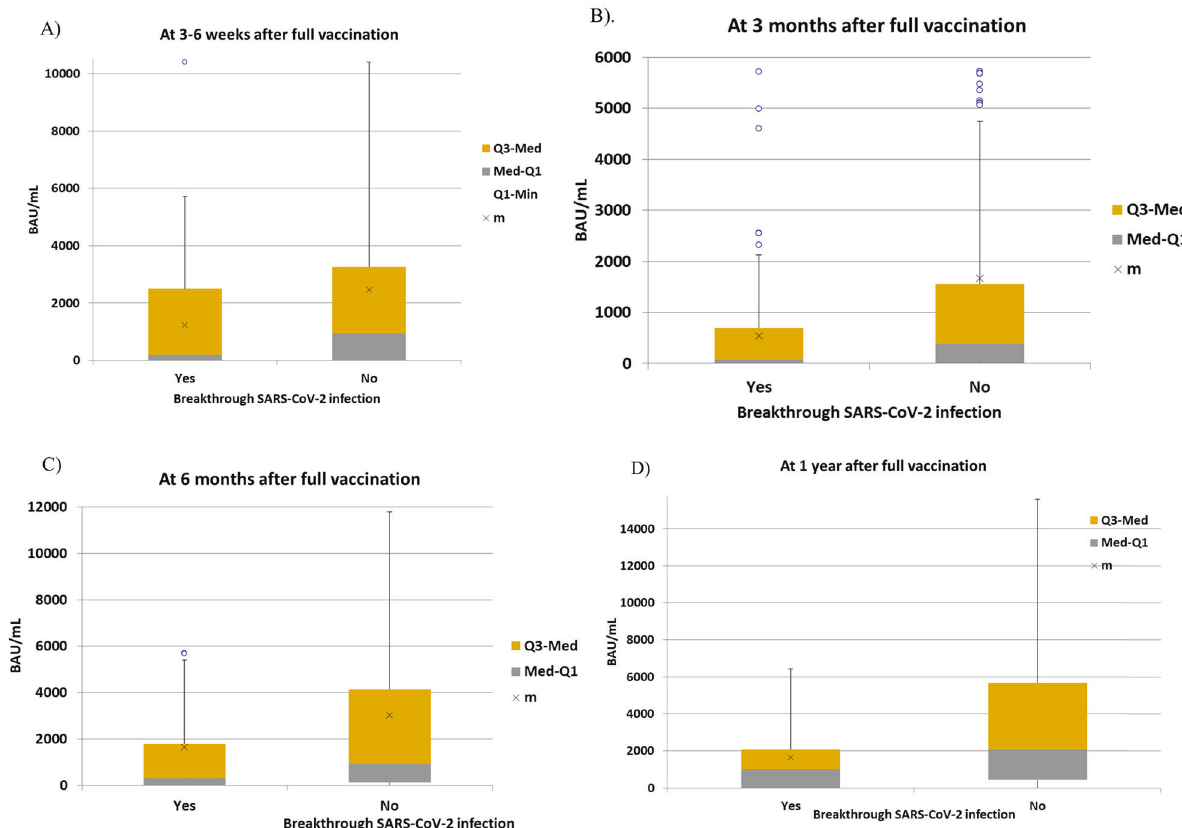
Fig. 3 Median anti-SARS-CoV-2 IgG reactive antibodies titers measured in binding antibody units/mL (BAU/mL) at 3 – 6 weeks, 3 months, 6 months and 1 year after the 2nd dose according to the development of breakthrough SARS-CoV-2 infection. A Patients with breakthrough SARS-CoV-2 infection had a median of 202.57 BAU/mL (range 0 – 5714) vs those without SARS-CoV-2 infection median 937 BAU/mL (range 0 – 10400) ( p < 0.001). B Q3-med means median interquartil 75%; Med-Q1, median interquartil 25%; m, mean. C Patients with breakthrough SARS-CoV-2 infection had a median of 70.14 BAU/mL (range 0 – 2126) vs those without SARS-CoV-2 infection median 379 BAU/mL (range 0 – 4746) ( p < 0.001). D Patients with breakthrough SARS-CoV-2 infection had a median of 302 BAU/mL (range 0 – 5408) vs those with SARS-CoV-2 infection median 907 BAU/mL (range 0 – 11800) ( p < 0.001). E Patients with breakthrough SARS-CoV-2 infection had a median of 1017 BAU/mL (range 0 – 6423) vs those without SARS-CoV-2 infection median 2080 (range 0 – 15600) (p <